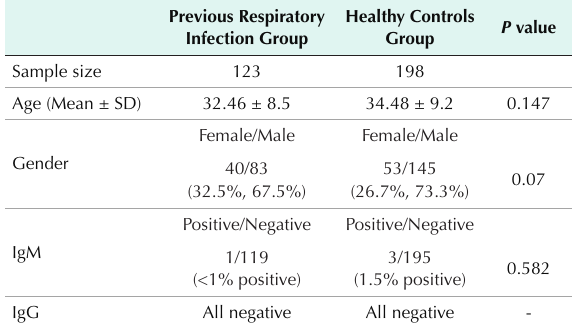
Table 1. Descriptive and Analytic Data of Study Groups Previous Respiratory Infection